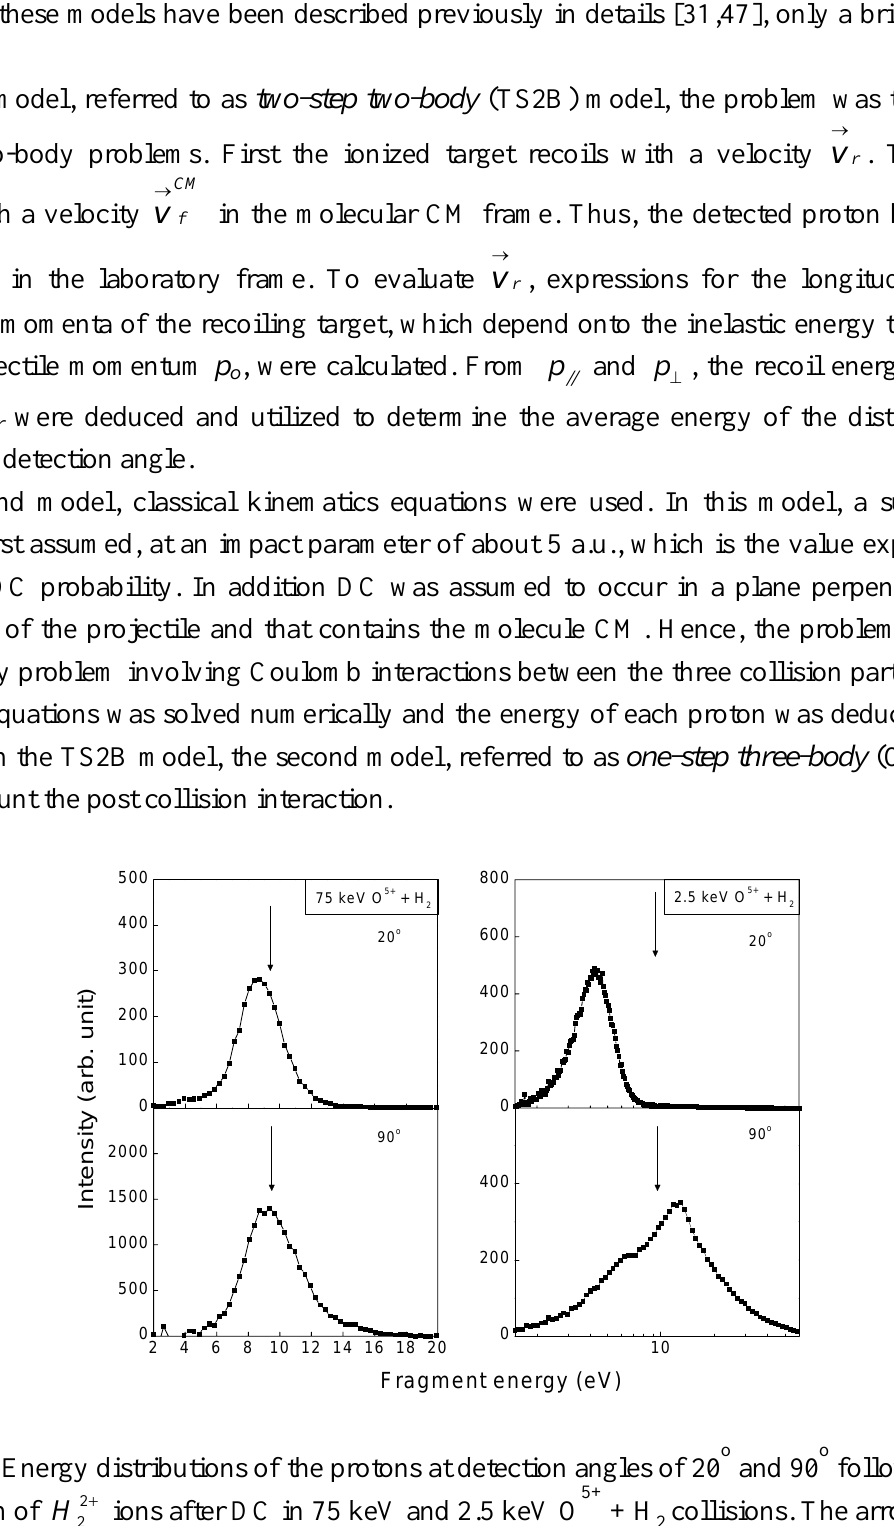
Figure 8. Energy distributions of the protons at detection angles of 20 H ions after DC in 75 keV and 2.5 keV O fragmentation of + 2 2 the expected energy assuming a free